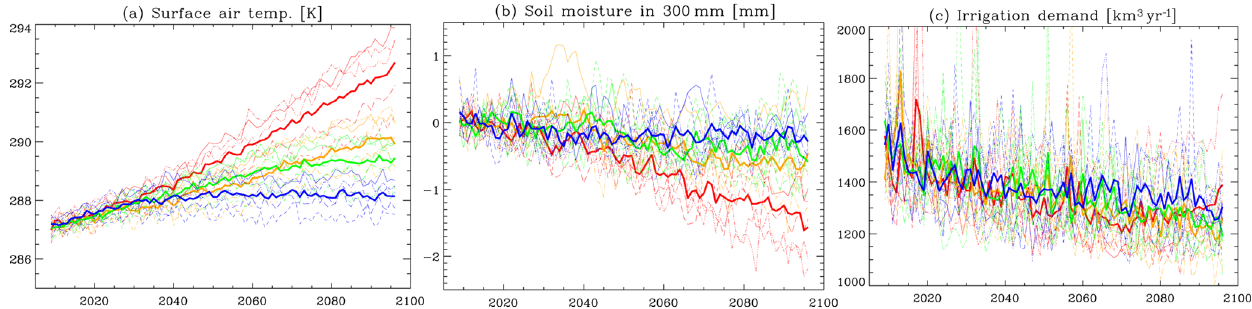
Figure 10. Time series of changes in the climate system based on the forcings of the five climate models. Results shown are for (a) surface air temperature (K); (b) soil moisture in the top 300mm of the soil column (mm), shown as an anomaly from first 20-year average; (c) irrigation water supply (km 3 yr − 1 ). Thin curves indicate the global average of results for each of the five climate model forcings. Thick curves show the overall average of results based on the five forcings. The colors indicate RCP2.6 (blue), RCP4.5 (green), RCP6.0 (orange), and RCP8.5